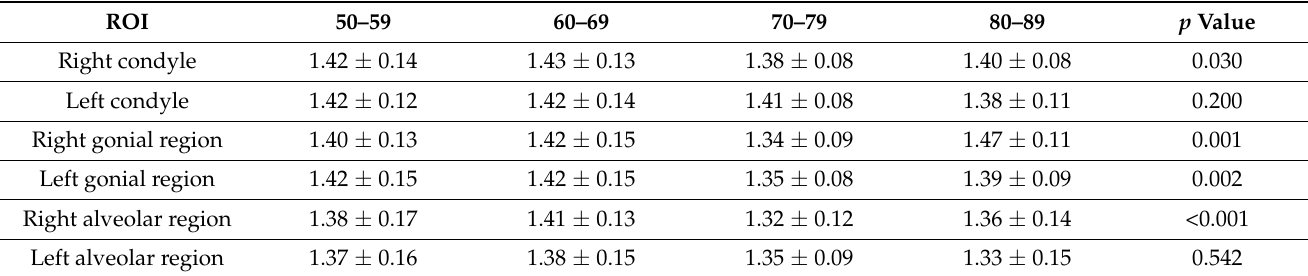
Table 5. Mean FDs ± standard deviation for different ROIs in different age